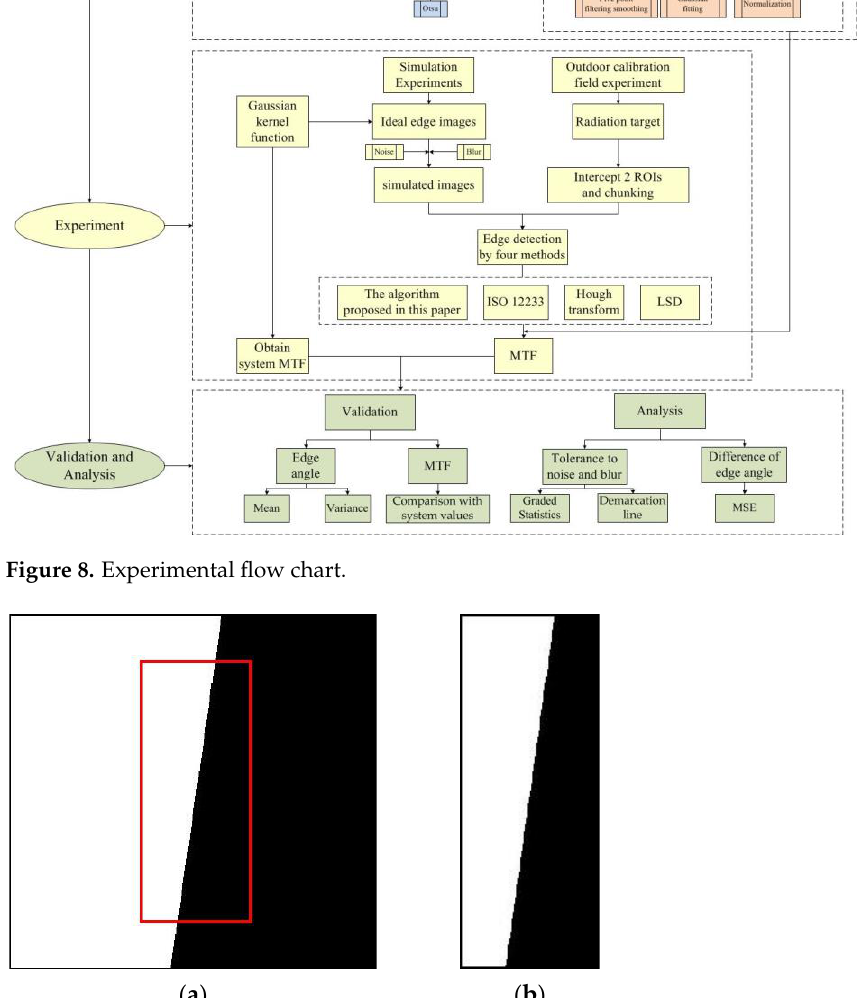
Table 1. Mean and variance of the edge angle deviation of the test results by different